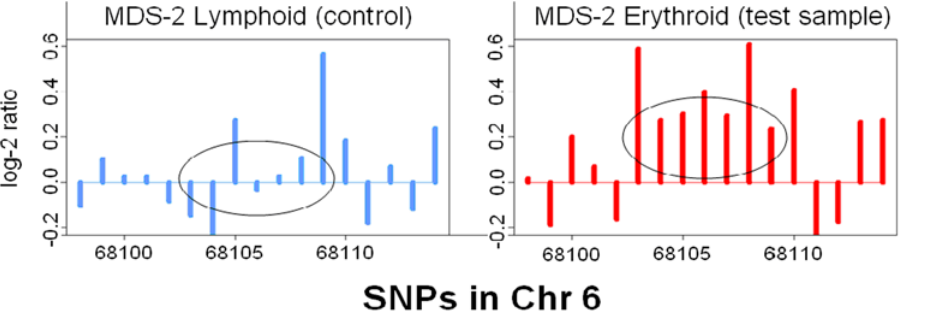
Figure 1. Illustration of the CMA algorithm. MDS-2 Lymphoid is the reference, and MDS-2 Erythroid is the test sample. In the test sample, the average log-2 intensities of every five consecutive SNPs in the circled region are higher than 0.35, with the small SDs ( , =0.15). Selected overlapping regions are merged into a large region.